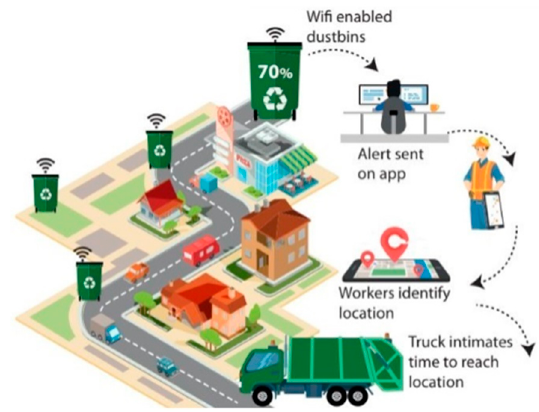
Figure 2. Overall system overview of SGCS.